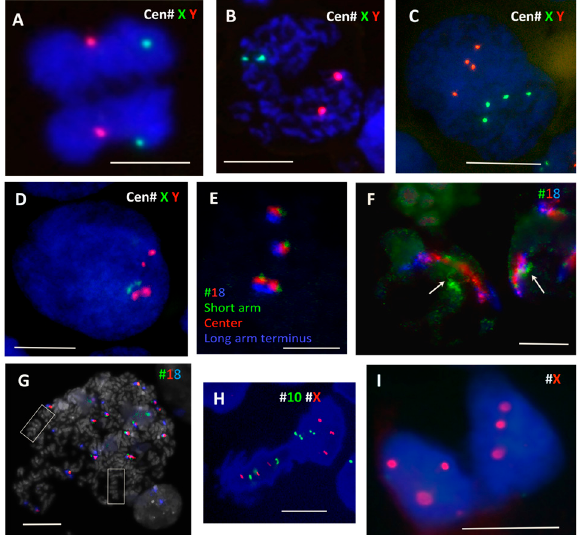
Figure 4. Fluorescence in situ hybridisation (FISH) studies of chromosome positions during polyploidisation and de-polyploidisation in genotoxically treated tumour cells. ( A – D ) PXT treatment of male diploid WIL2NS cells reveal the following: ( A ) Separation of both #X (green) and #Y (red) specific centromere labels in anaphase. ( B ) Two X, Y centromere signals each in two connected chromosome groups 19 h after inactivation of the spindle with PXT. ( C ) Four centromeric signals of each sex chromosome opposing each other in an octoploid cell, 44 h after PXT treatment. ( D ) Replicated #X and #Y centromere signals cohesed as dyads, characteristic for 2 days after PXT treatment. ( E – G ) Position of homologues and multiple #18 labels revealed by a three-colour (p: green; centre: red; terminus q: blue) painting probe in 10 Gy-treated Namalwa lymphoma cells. ( E ) Control metaphase chromosome 18 after triple labelling. ( F ) Extended territories of #18, touching at green p-ends (arrows) in polygenomic nuclei on 6 days post 10 Gy. ( G ) Large endomitotic polyploid metaphase cell displaying co-parallel orientation of condensed chromosomes (boxed) with 16 territories of condensed chromosome 18 (7 days post-IR). ( H , I ) Bipolar division of polyploidised (normally para-triploid) HeLa cells showing on ( H ) the meiosis I-like reduction segregation of three pairs of binemic chromatids for #10 (green) and #X (red). ( I ) Segregation of uni-nemic chromatids as indicated by centromeric signals for #X in HeLa cells (10 Gy, Day 2). Bars equal 10 µM.